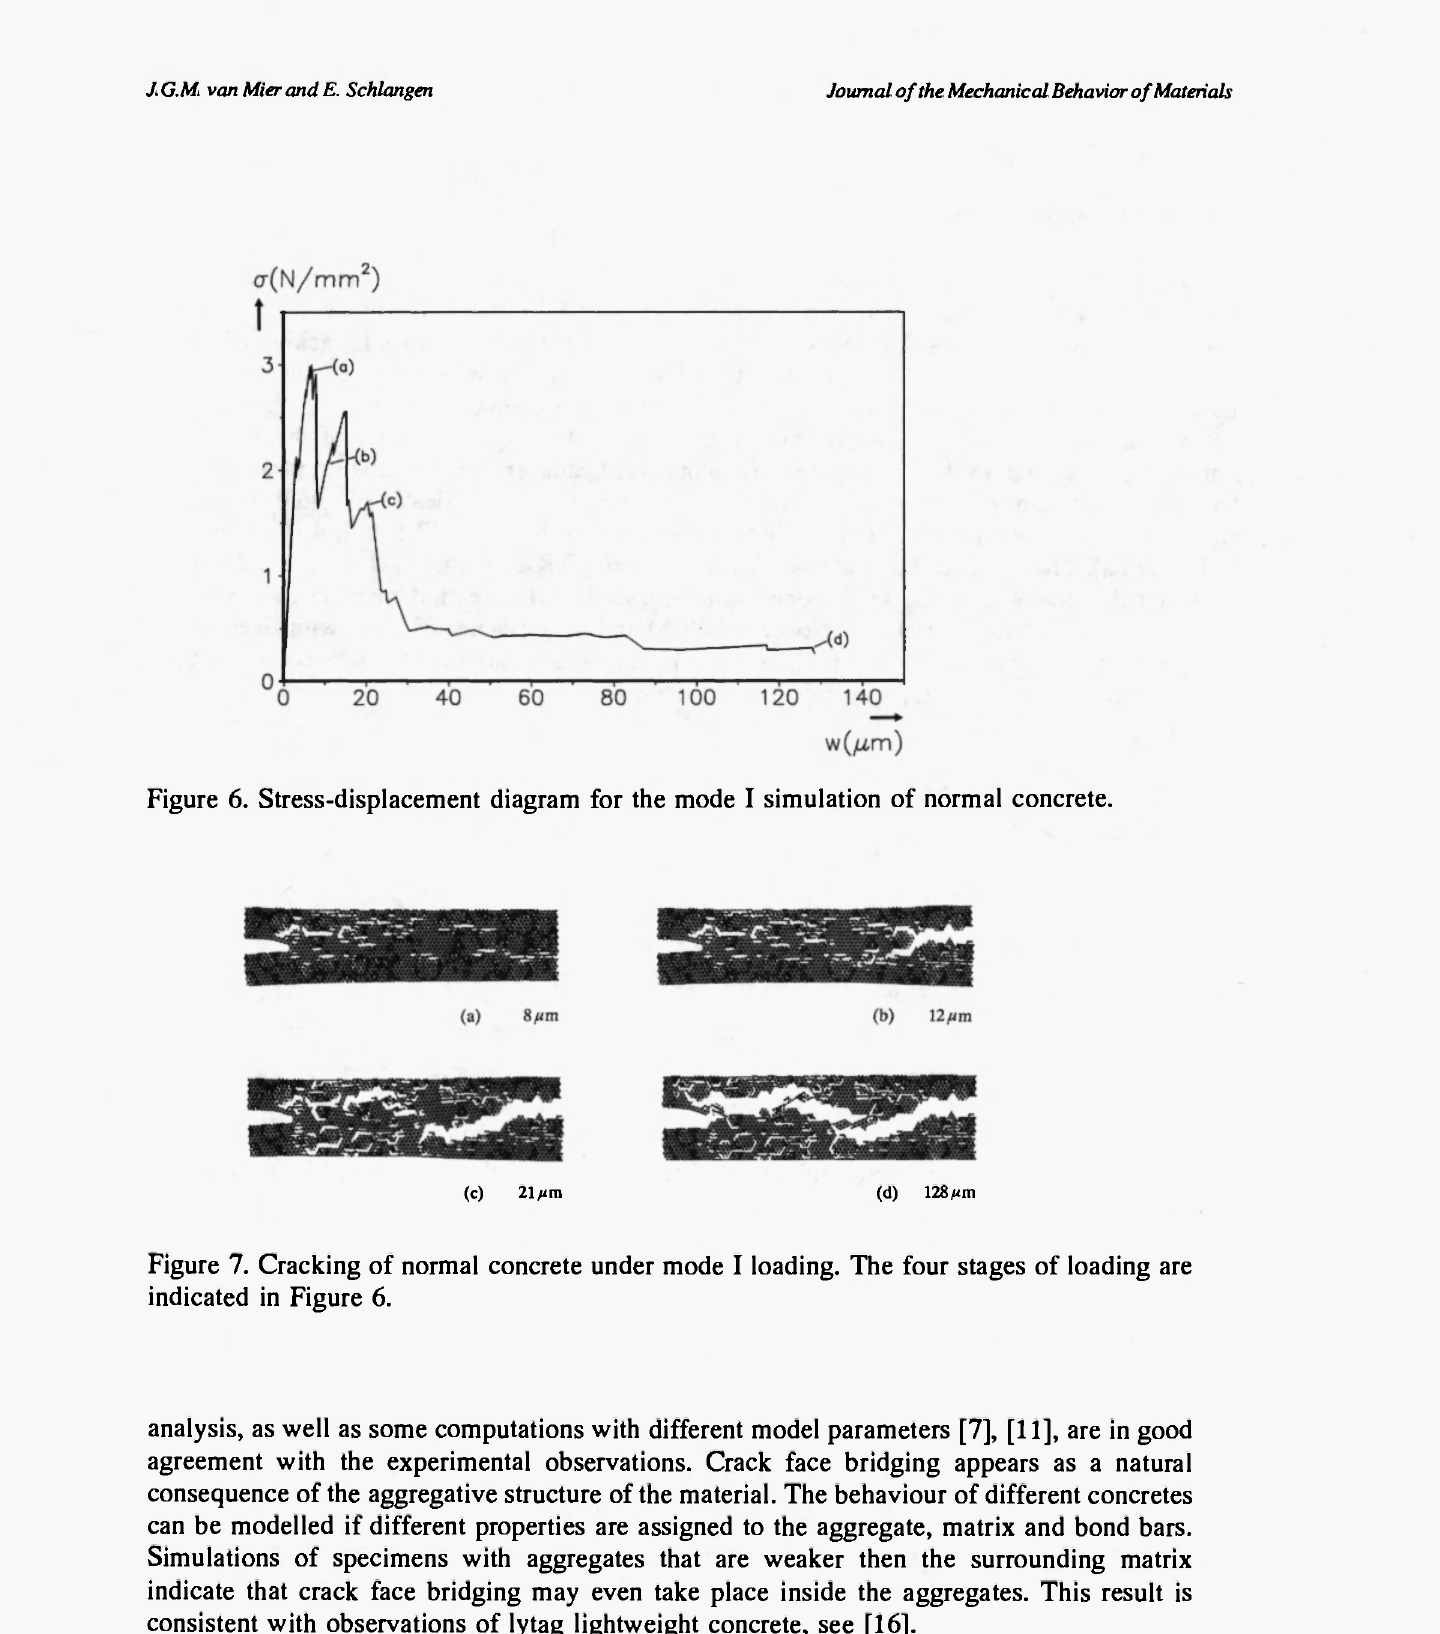
Figure 6. Stress-displacement diagram for the mode I simulation of normal concrete.